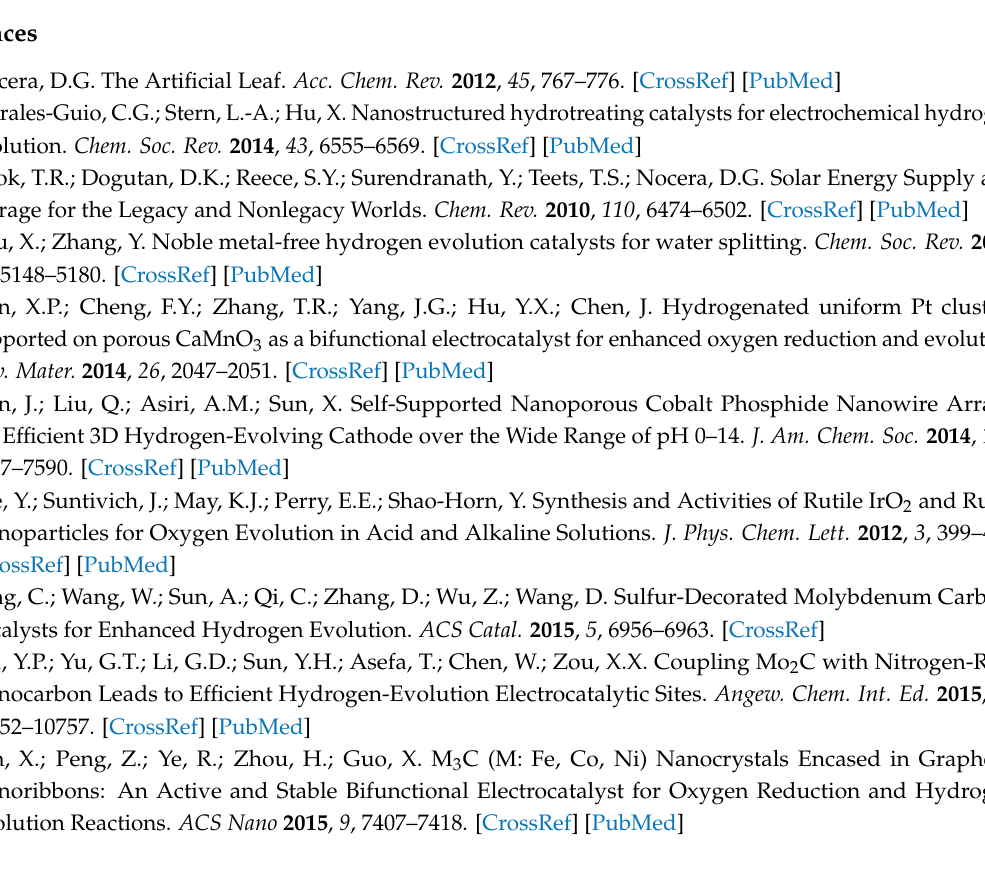
Figure S1: SEM images of precursors, Figure S2: Low-magnification SEM, Figure S3: EDS spectra, Figure S4: Measurement of lattice distance, Figure S5: TEM and HRTEM images of Ni 0.5 Co 0.5 S 2 and Ni 0.67 Co 0.33 S 2 , Figure S6: OER performance of monometallic CoS 2 and NiS 2 , Figure S7: SEM images of Ni–Co–S NN after OER polarization for 15,000 s, Figure S8: HER performance of monometallic CoS 2 and NiS 2 , Figure S9: C dl measurements, Table S1: 2 θ degree of selected crystal planes in prepared samples, Table S2: Comparison of OER performances of Ni 0.33 Co 0.67 S 2 NN/SS with other reported non-noble metal OER electrocatalysts in 1.0 M KOH, Table S3: Comparison of overall water-splitting performances of Ni 0.33 Co 0.67 S 2 NN/SS with other reported non-noble metal electrocatalysts in 1.0 M